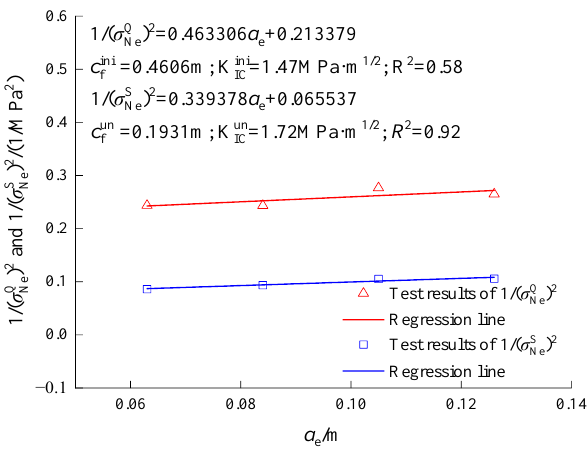
(cid:16) (cid:17) 2 (cid:0) (cid:1) 2 Figure 13. Linear relationships of 1/ σ Q σ S , 1/ and a e . Figure 13. Linear relationships of and a e . Ne Ne The K ini and c ini and K un and c un obtained by linear analysis are substituted into IC IC f f Equations (8) and (9), respectively, and the relationship between the initiation and peak loads with the equivalent geometric parameter ( A e ) can be obtained as shown in Figure 14. In the figure, the slope of the initiation load prediction line is K ini without size effect, and IC the slope of the peak load prediction line is K un without a size effect. It can be seen from IC Figure 7 that the test results of F HQ and F Hmax are nearly linear relative to A e . The MAPE of F HQ prediction is 0.99%, RMSE is 0.22 kN, reliability index a 15 is 100% and the covariance is 5.43 (kN) 2 . The MAPE of F Hmax prediction is 1.5%, RMSE is 0.19 kN, a 15 is 100% and the covariance is 12.01 (kN) 2 . The above indices show that the size effect model can realize the accurate prediction of initiation and peak loads when the size or α c changes.